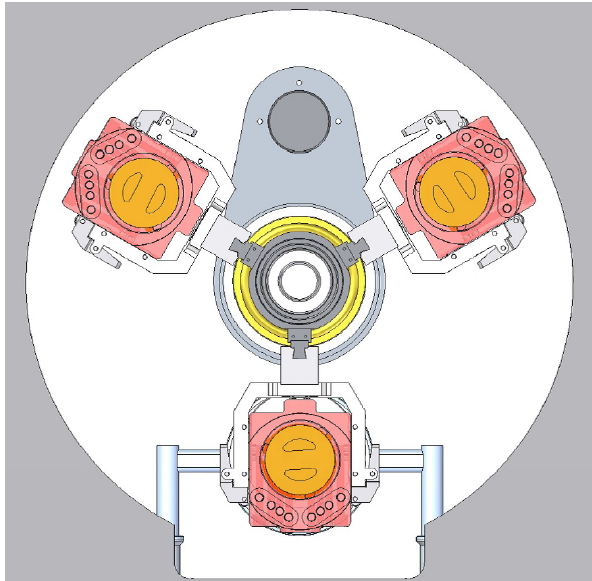
Figure 5. Close-up view of a target magazine with target holders loaded in all three positions. The target at the bottom is located on the beam axis (see also caption to Figure